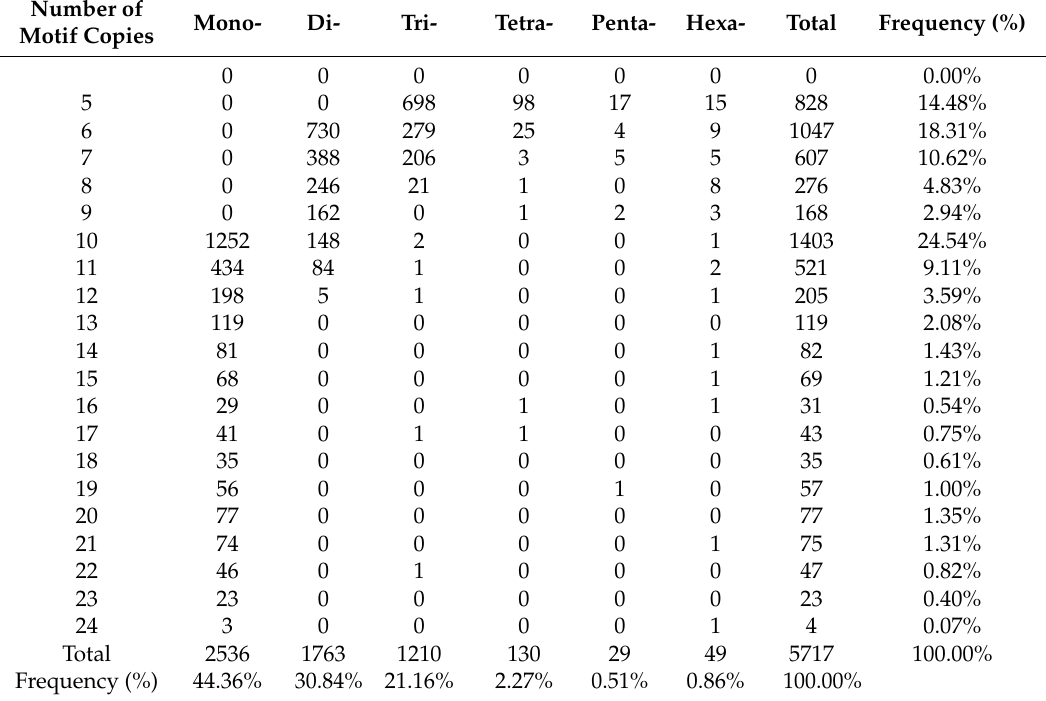
Table 4. Frequency of different repeat motif in